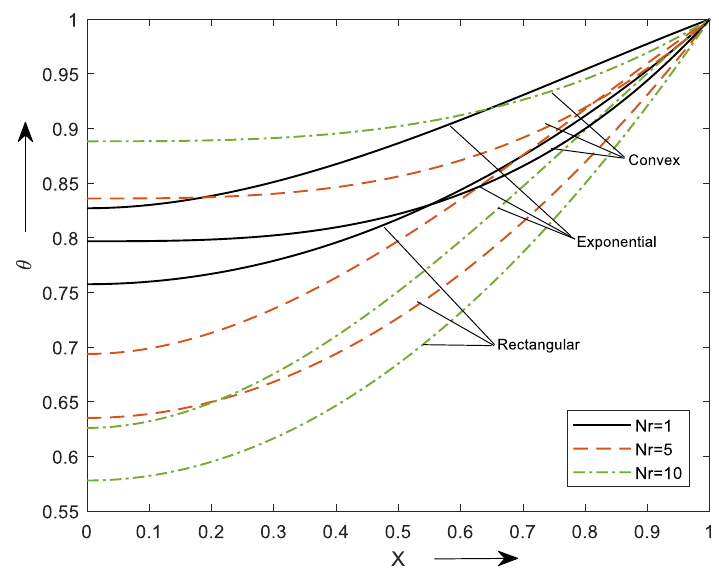
Figure 6. Behavior Nr on θ.